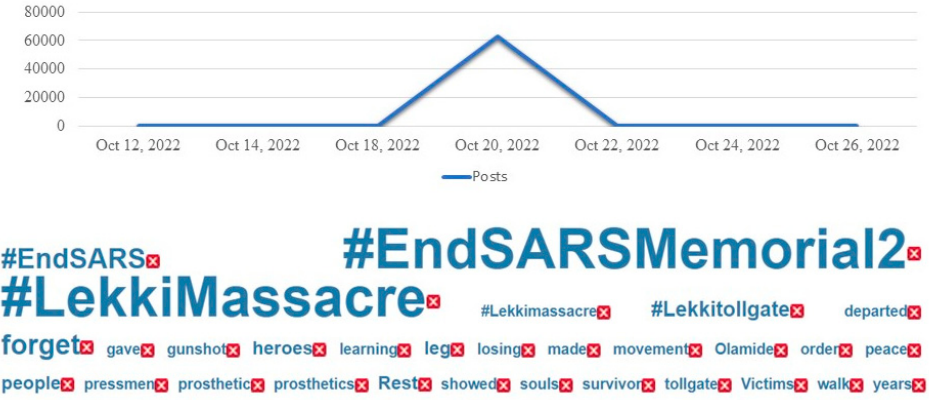
Figure 1. Word cloud and data collection dates.